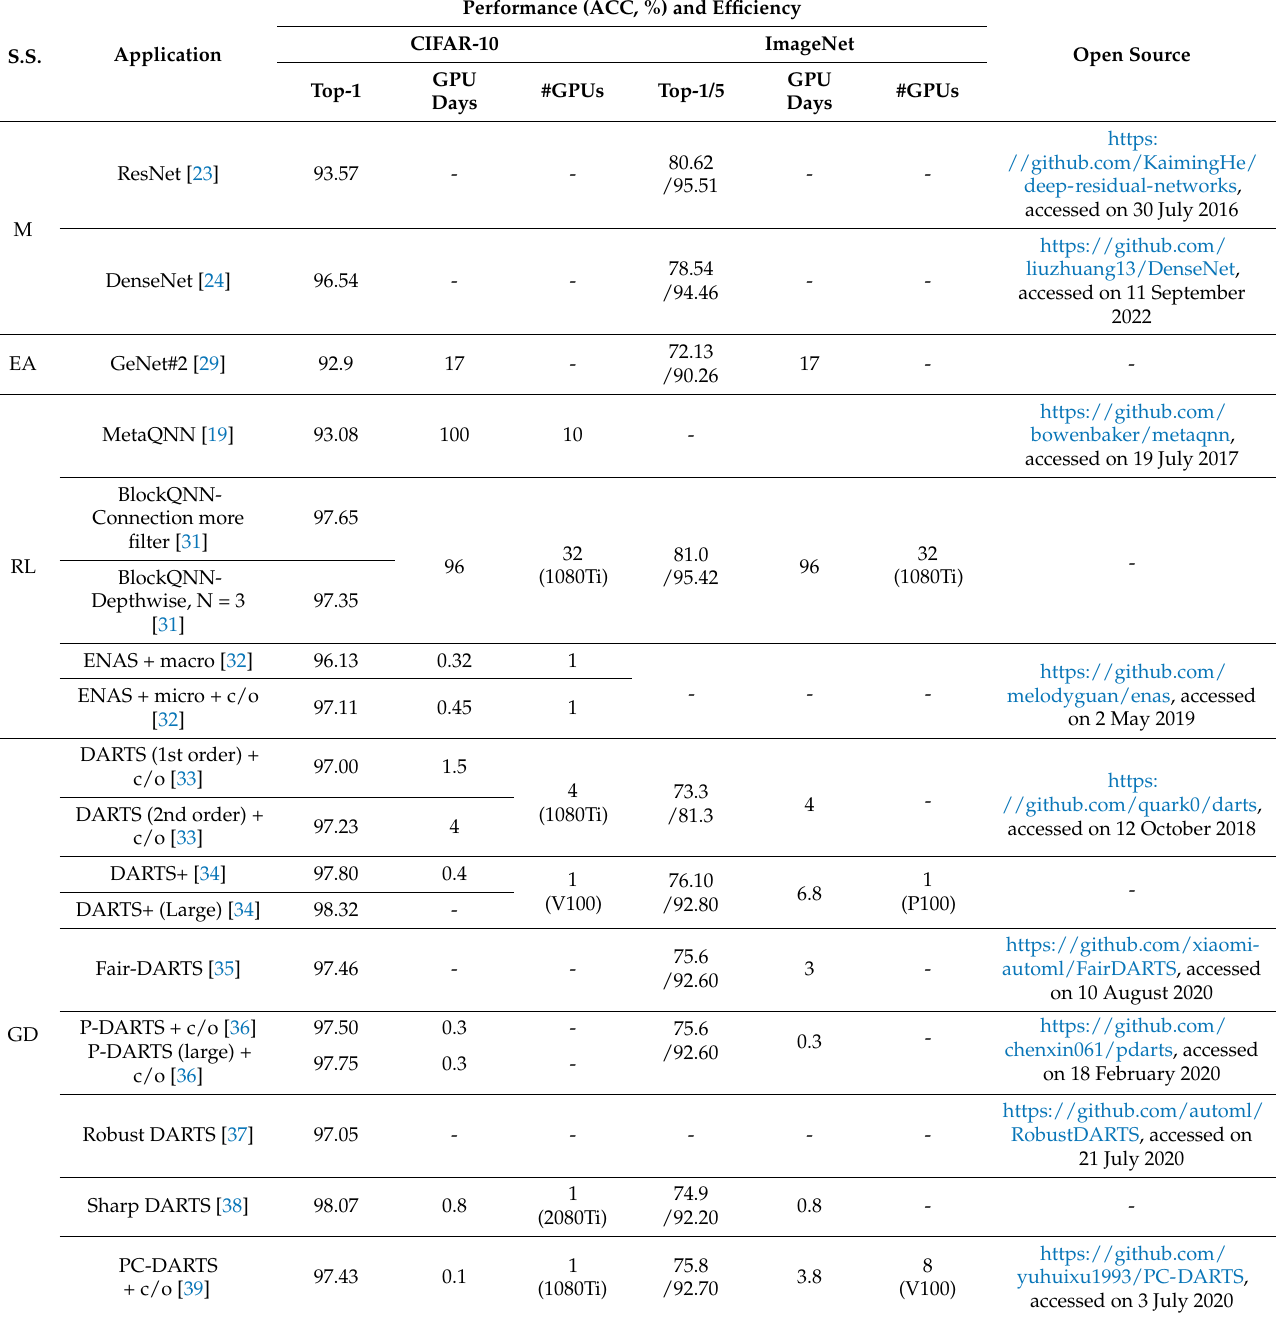
Table 1. Performance and Efficiency of NAS Algorithms on CIFAR-10 and ImageNet. The ‘S.S’ column indicated the search strategy. The dash (-) indicates that the corresponding information is not provided in the original